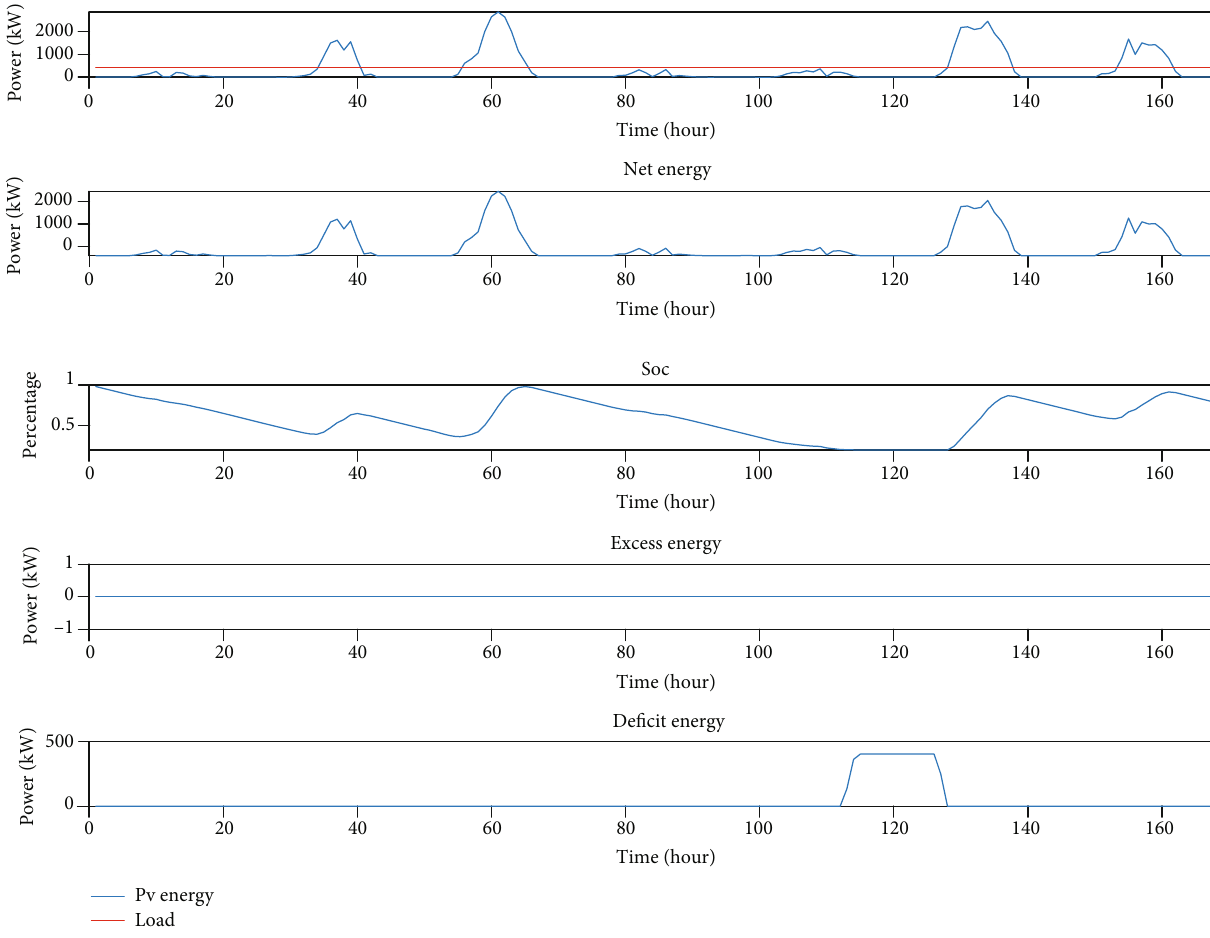
Figure 14: System performance sample for the second scenario: Nablus